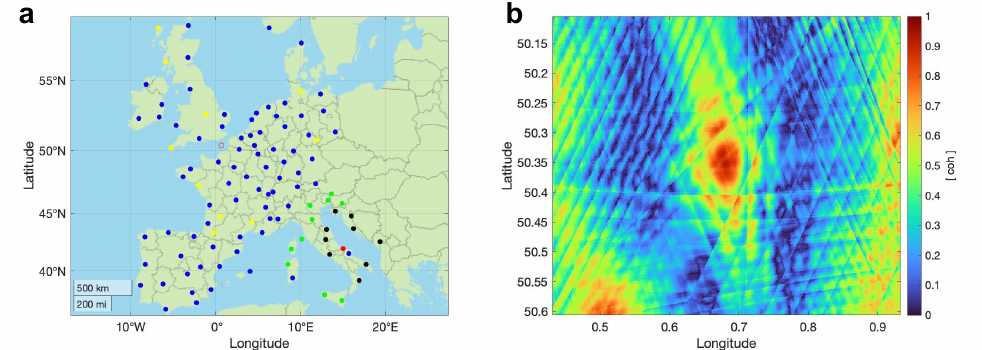
Figure 4. ( a ) Simulated lightning locations (red open circle and red dot) and receiver distribution in Europe (all the dots except two red dots). The red open circle is the simulated lightning location using the averaged waveforms from the amplitude waveform bank, and the red dot is the simulated lightning location of 15°E and 42°S. Yellow dots are the receiver used in the simulation with averaged waveforms from the amplitude waveform bank; black dots are the 10 receivers used in a small receiver network ( N = 10); the black dots and green dots are the 20 receivers used in small receiver network ( N = 20). ( b ) The calculated coherency map by using the amplitude waveforms from the amplitude waveform bank. The coherency map has a latitude and longitude range of 0.5° × 0.5°, with a precision of 0.001° ×